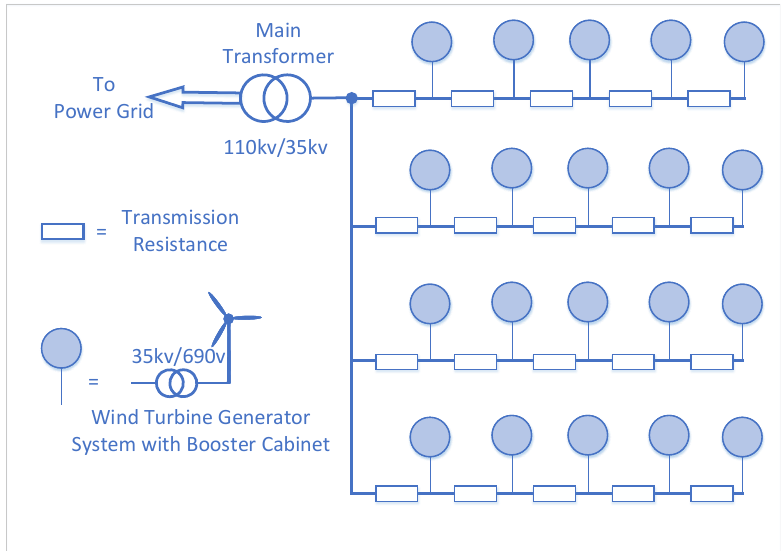
Figure 2. Wind farm topology and bus